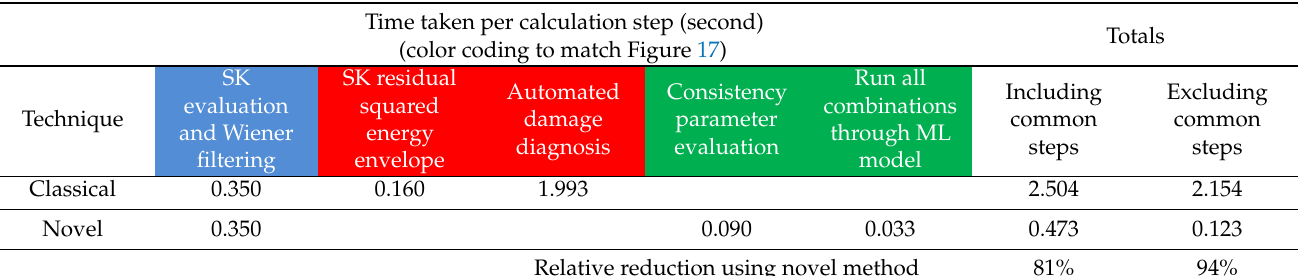
Table 2. Comparative computation time (seconds) between